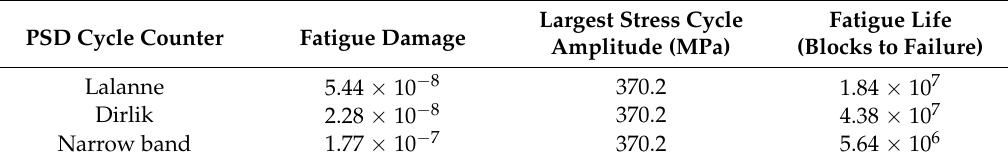
Table 10. Fatigue life using absolute maximum principal stress under rural road excitation.